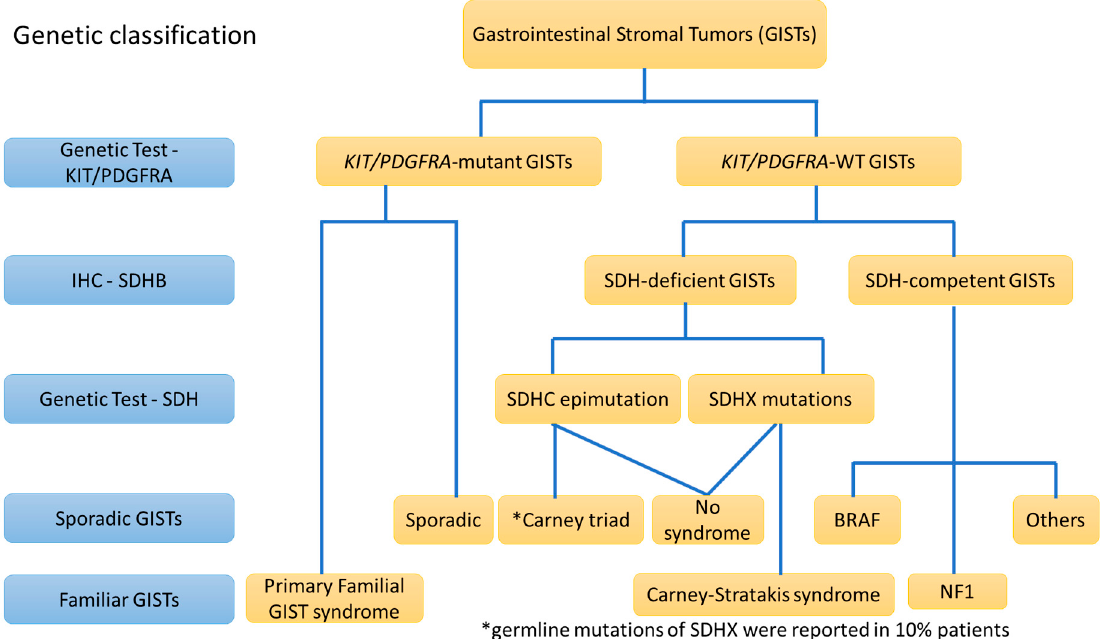
Figure 3. The genetic classification of GISTs. GISTs is subgrouped into KIT / PDGFRA -mutant and KIT / PDGFRA -WT GISTs. KIT / PDGFRA -WT GISTs can be subgrouped into succinate dehydrogenase (SDH)-deficient and SDH–competent GISTs according to SDH expression. Most of mutations are sporadic but some are germline mutations which are related to syndromic or familiar GISTs.